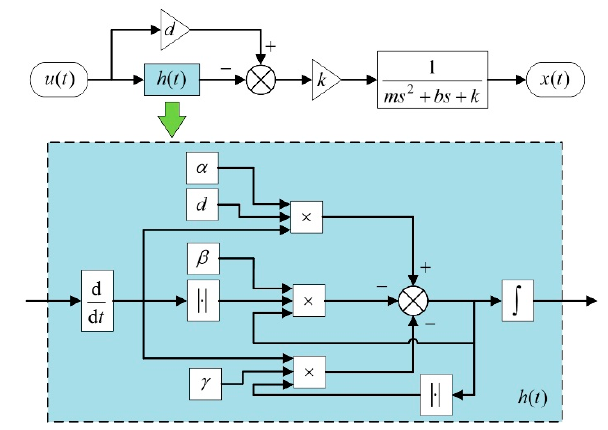
Figure 4. Block diagram of the proposed hysteresis model.